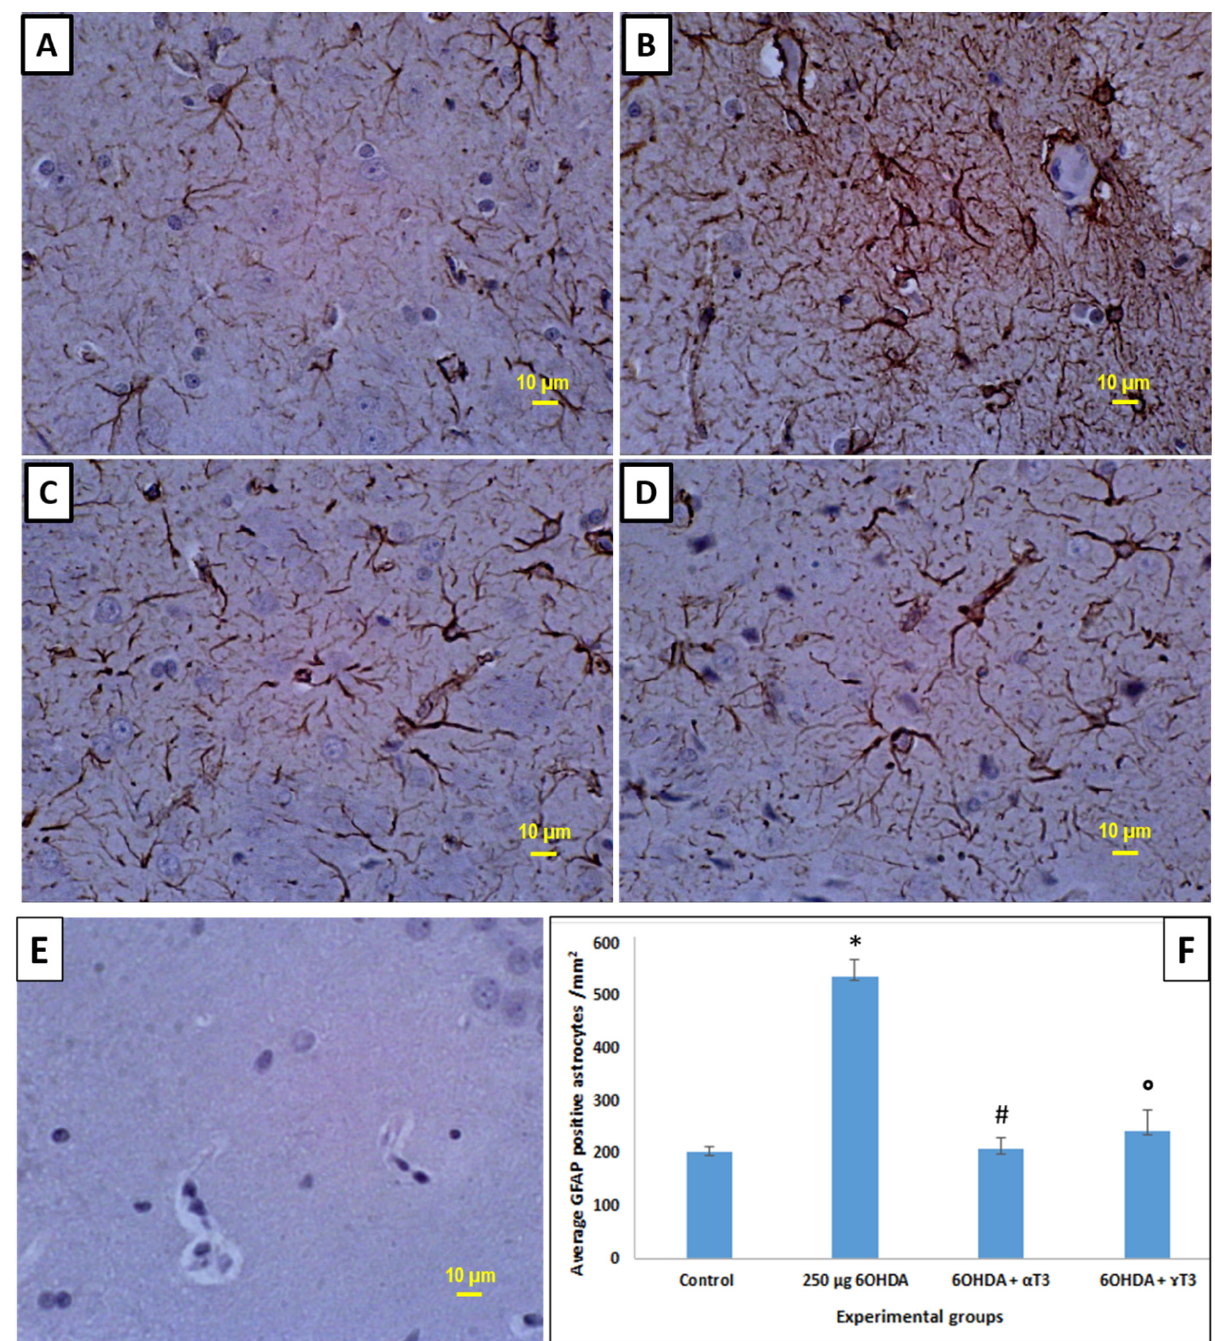
Figure 7. Photomicrographs showing the expression of glial fibrillary acidic protein (GFAP) in striatum (STR) from the ( A ) control group, ( B ) 250 µg 6-OHDA-injected group, ( C ) 250 µg 6-OHDA + α -T3-treated group, ( D ) 250 µg 6-OHDA + γ -T3-treated group, and ( E ) negative control without primary antibody for GFAP and ( F ) bar chart showing the quantification of GFAP positive astrocytes in STR of A–D. (Scale Bar: 10 µm; n = 6; * p < 0.05 vs. control; # p < 0.05 vs. 250 µg 6-OHDA; ° p < 0.05 vs. 250 µg 6-OHDA).